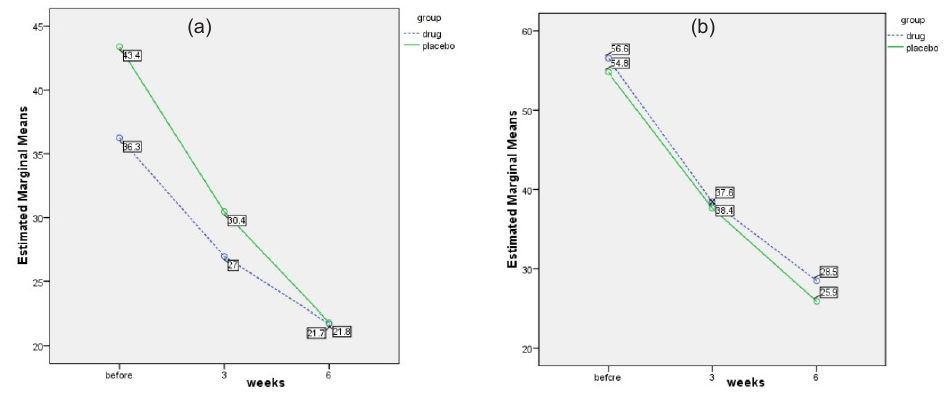
Figure 2. Comparison of the mean (a) negative and (b) positive symptoms of PANNS scores between the simvastatin and placebo group at weeks 0, 3 and